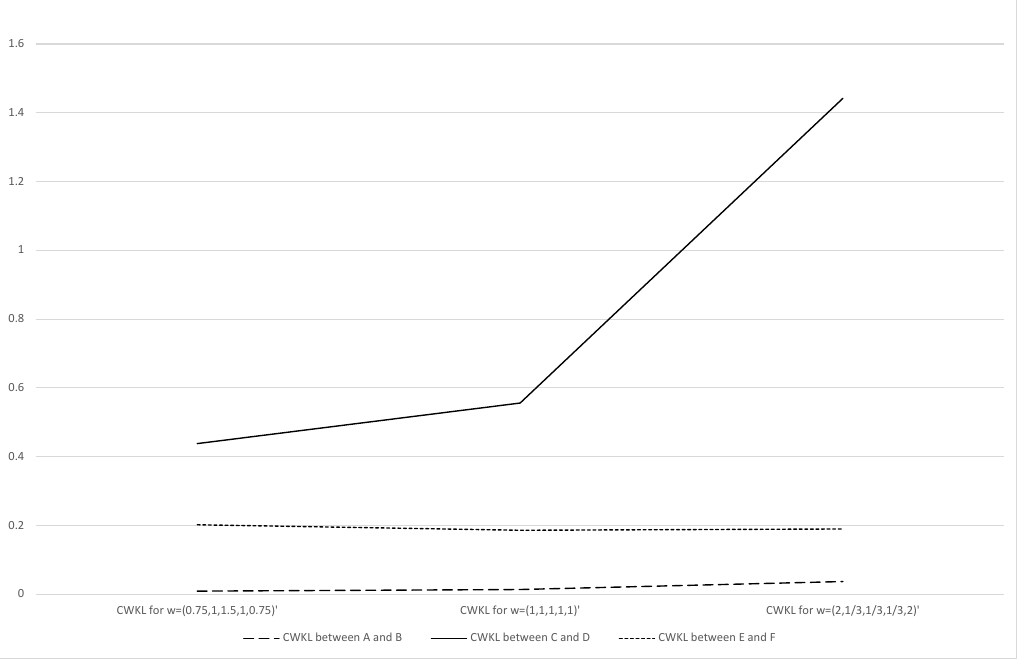
Figure 2. CWKL divergence between assets.